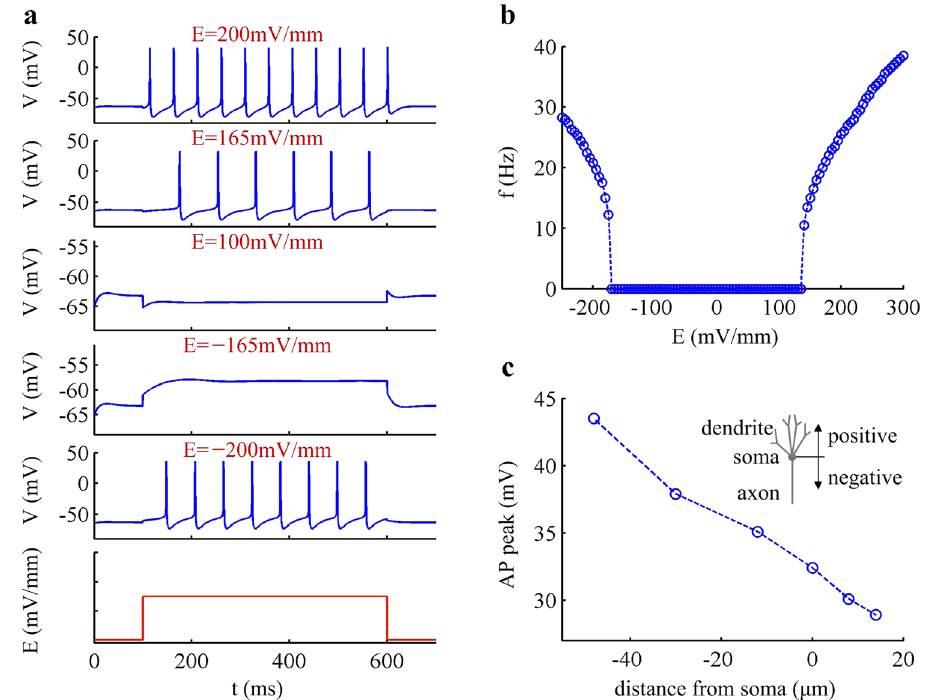
Figure 1. Responses of artificial neuron with specific morphology to EFs. ( a ) Typical spike trains recorded in the midpoint of the soma with several values of EF, which are indicated on the top of relevant panel. Bottom panel is used to indicate the time of the onset and offset of applied field. ( b ) Relationship between somatic firing rate and EF, i.e., f - E curve. ( c ) Peak value of the AP recorded at different sites of the artificial model. Relevant morphological parameters of soma, axon and dendrites take their initial value.